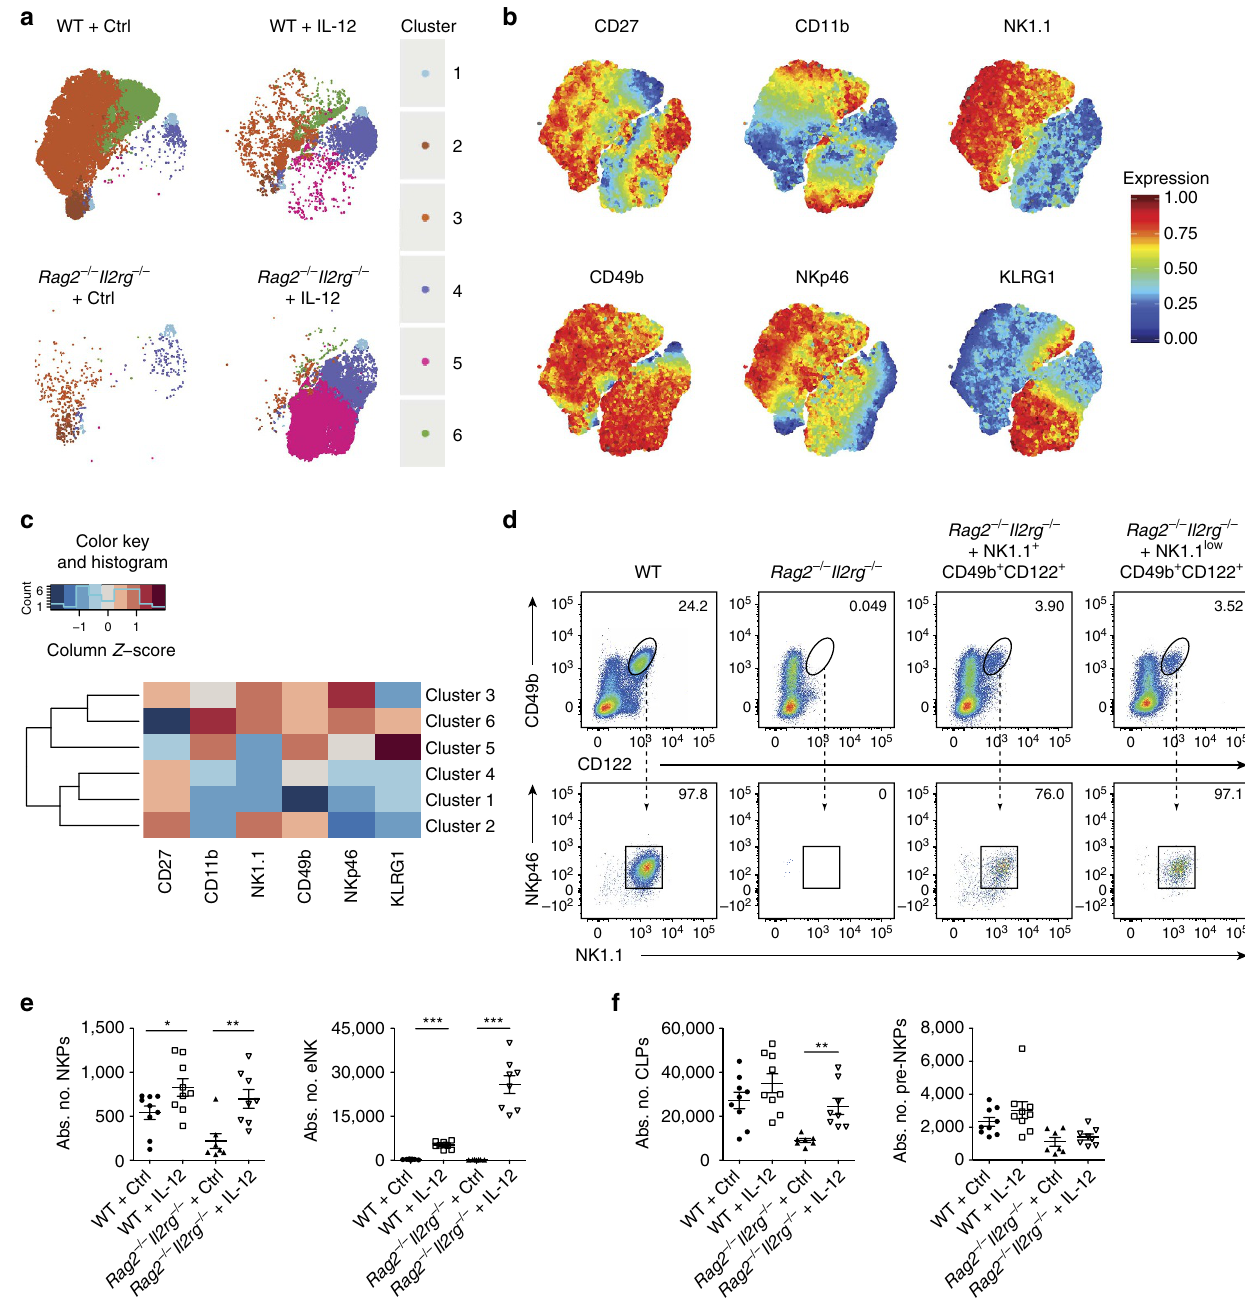
Figure 4 | IL-12 induces expansion of eNK cells in the BM via an alternative developmental pathway. ( a ) tSNE dimensions 1 and 2 for CD45 þ Lin (cid:2) CD122 þ cells derived from the BM of Ctrl- or IL-12-treated WT or Rag2 (cid:2) / (cid:2) Il2rg (cid:2) / (cid:2) mice. ( b ) Annotated t-SNE maps depicting CD27, CD11b, NK1.1, CD49b, NKp46 and KLRG1 in the six identified clusters. ( c ) Heat map summary of average median expression of each cellular marker analysed for six clusters. ( d ) Adoptively transferred splenic CD45 þ CD3 (cid:2) CD122 þ CD49b þ NK1.1 þ and CD45 þ CD3 (cid:2) CD122 þ CD49b þ NK1.1 low cells into Rag2 (cid:2) / (cid:2) Il2rg (cid:2) / (cid:2) mice were analysed in lungs at day 7 after transfer for expression levels of NK1.1. Two independent experiments were performed. ( e ) Quantification of NKPs and eNK cells in the BM of Ctrl- or IL-12-treated WT and Rag2 (cid:2) / (cid:2) Il2rg (cid:2) / (cid:2) mice. Data are pooled from two independent experiments. ( f ) Quantification of CLPs and pre-NKPs in the BM of Ctrl- or IL-12-treated WT and Rag2 (cid:2) / (cid:2) Il2rg (cid:2) / (cid:2) mice. Data are pooled from two independent experiments. Each dot represents one mouse. Data are expressed as mean ± s.e.m. * P o 0.05, ** P o 0.01, *** P o 0.001 (unpaired Student’s t -test with Welch’s